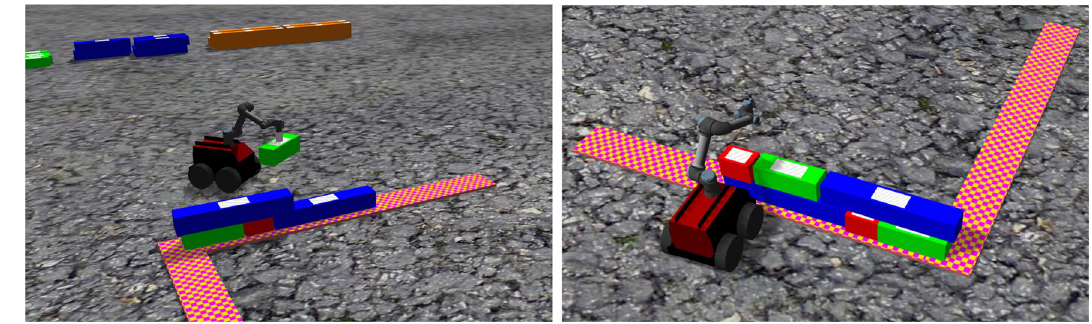
Fig. 16 Snapshots from a simulation where the mobile manipulator is building a 2 layer wall consisting of 6 bricks